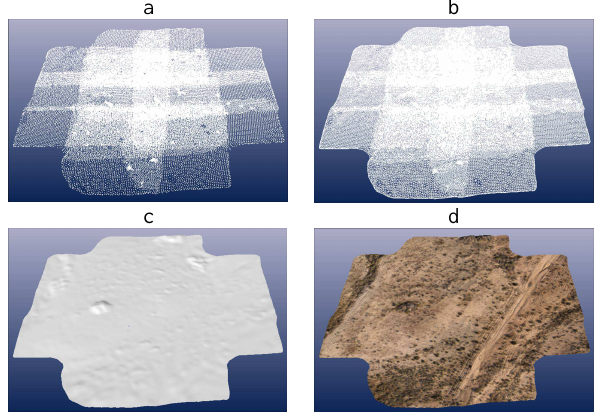
Figure 4. Details of the dense point cloud (a), triangulated points (b), shaded surface (c) and textured surfaced of the tested area (d) obtained from the photogrammetric process Basing on the point cloud exported, a DEM was generated by the interpolation of regular grids using the radial basis function method (figure 5). The DEM was interpolated with a 10 cm grid. Contour lines were obtained by intersection of the DEM and a set of 0.5 m interval parallel planes to the horizontal